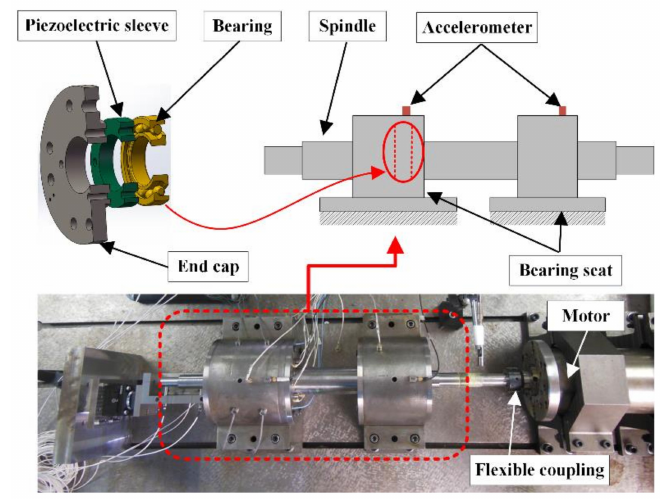
Figure 10. Bearing non-uniform preload test bench.